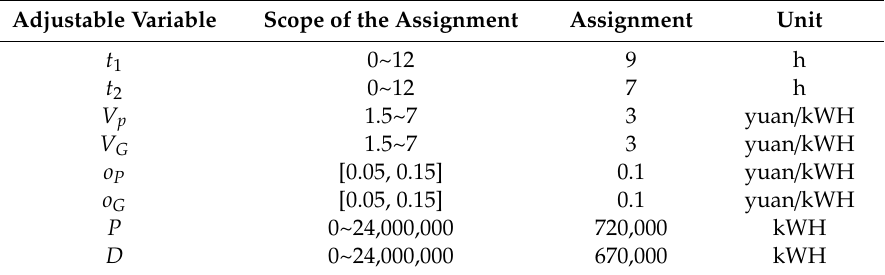
Table 6. Reference range for the initial assignment of adjustable parameters. Adjustable Variable Scope of the